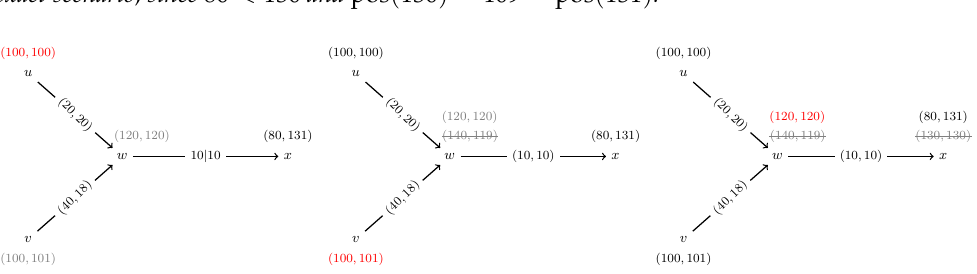
Figure 3. Three consecutive iterations of the MD-FPTAS. The extracted label (cid:96) ∗ in every iteration is marked in red, the permanent labels (cid:96) ∈ L v in black, and the tentative labels generated in nextCandidateLabel or propagate in